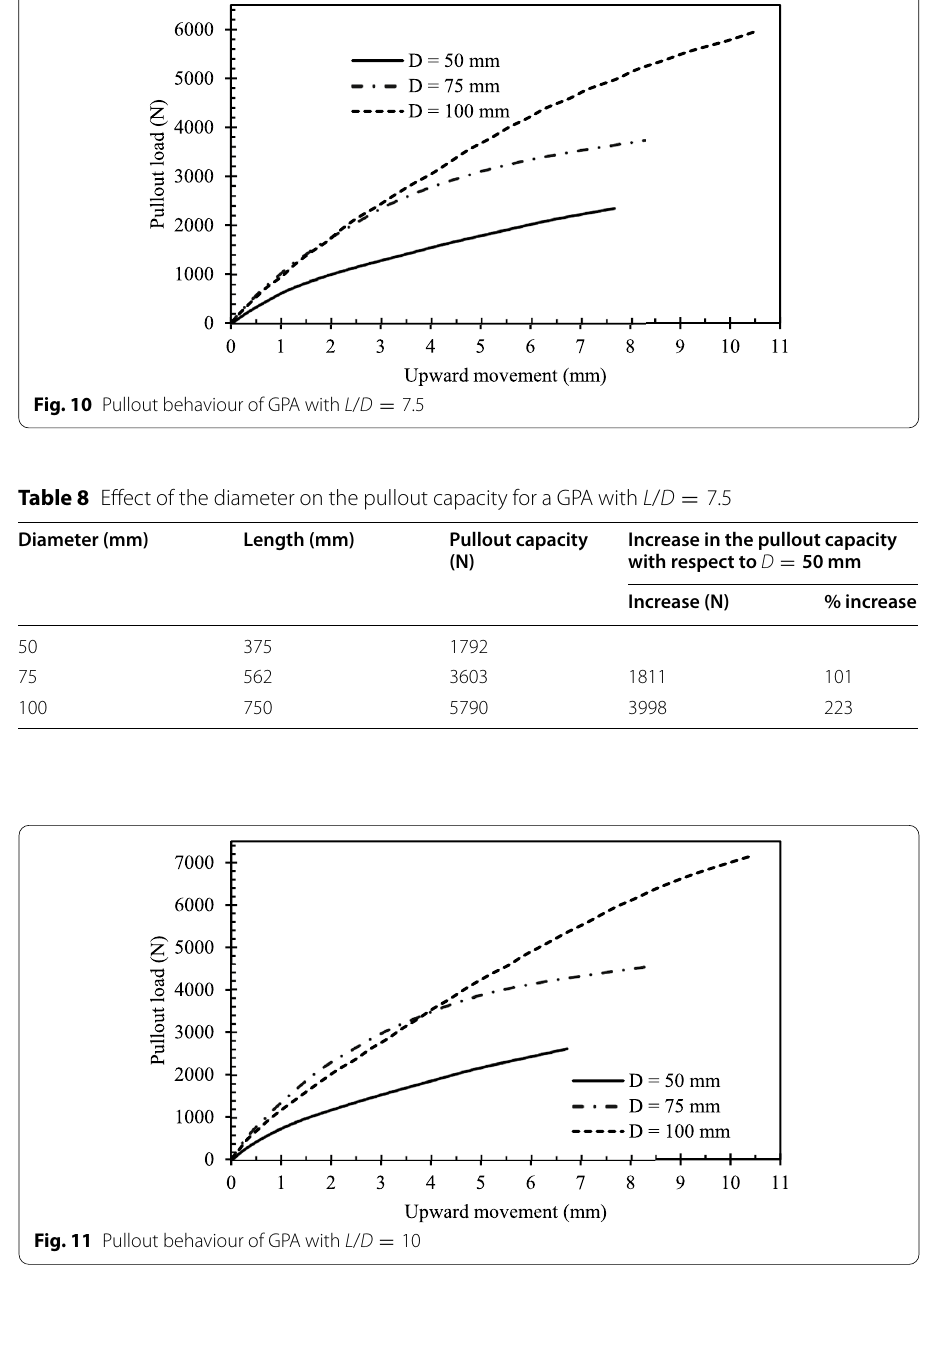
Constant L / D ratio 10